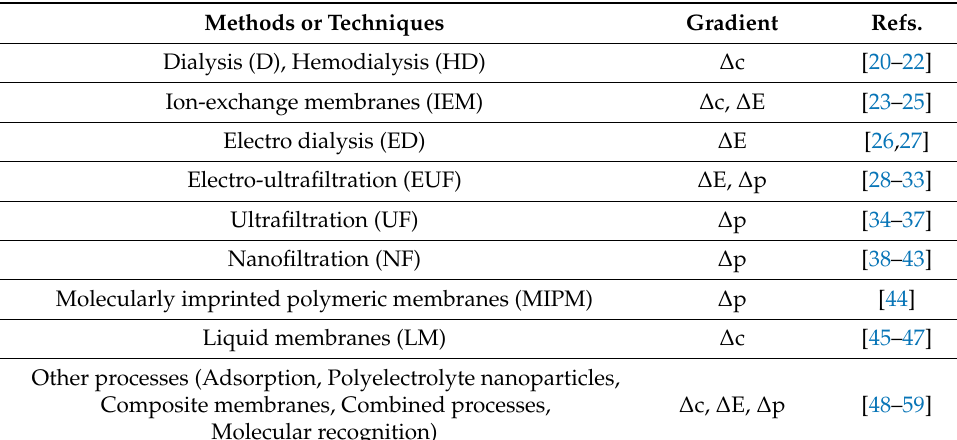
Table 1. Membrane amino acids separation techniques and